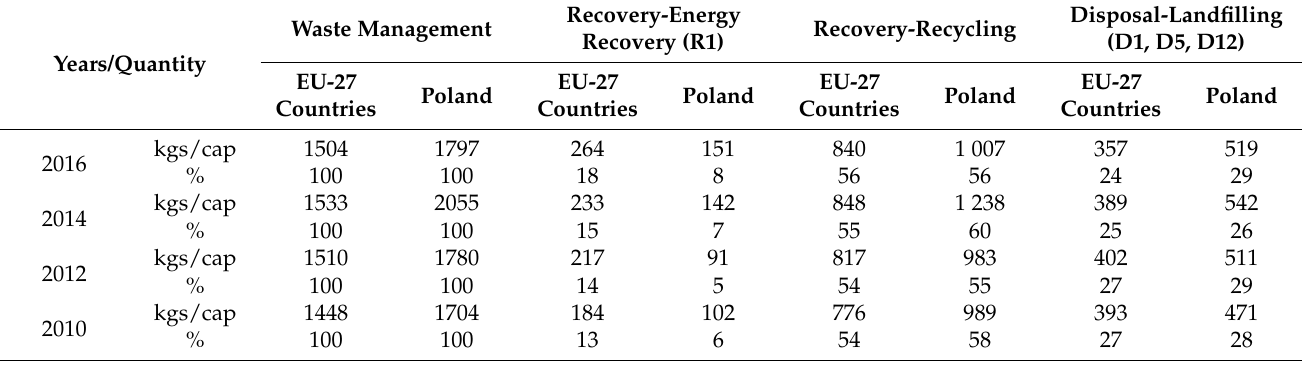
Rows: years/kilograms per capita and percentage; columns: waste management operations/EU and Poland Source: Eurostat, https://ec.europa.eu/eurostat/databrowser/view/ENV_WASOPER__custom_735567/default/table?lang=en. (accessed on 31 June